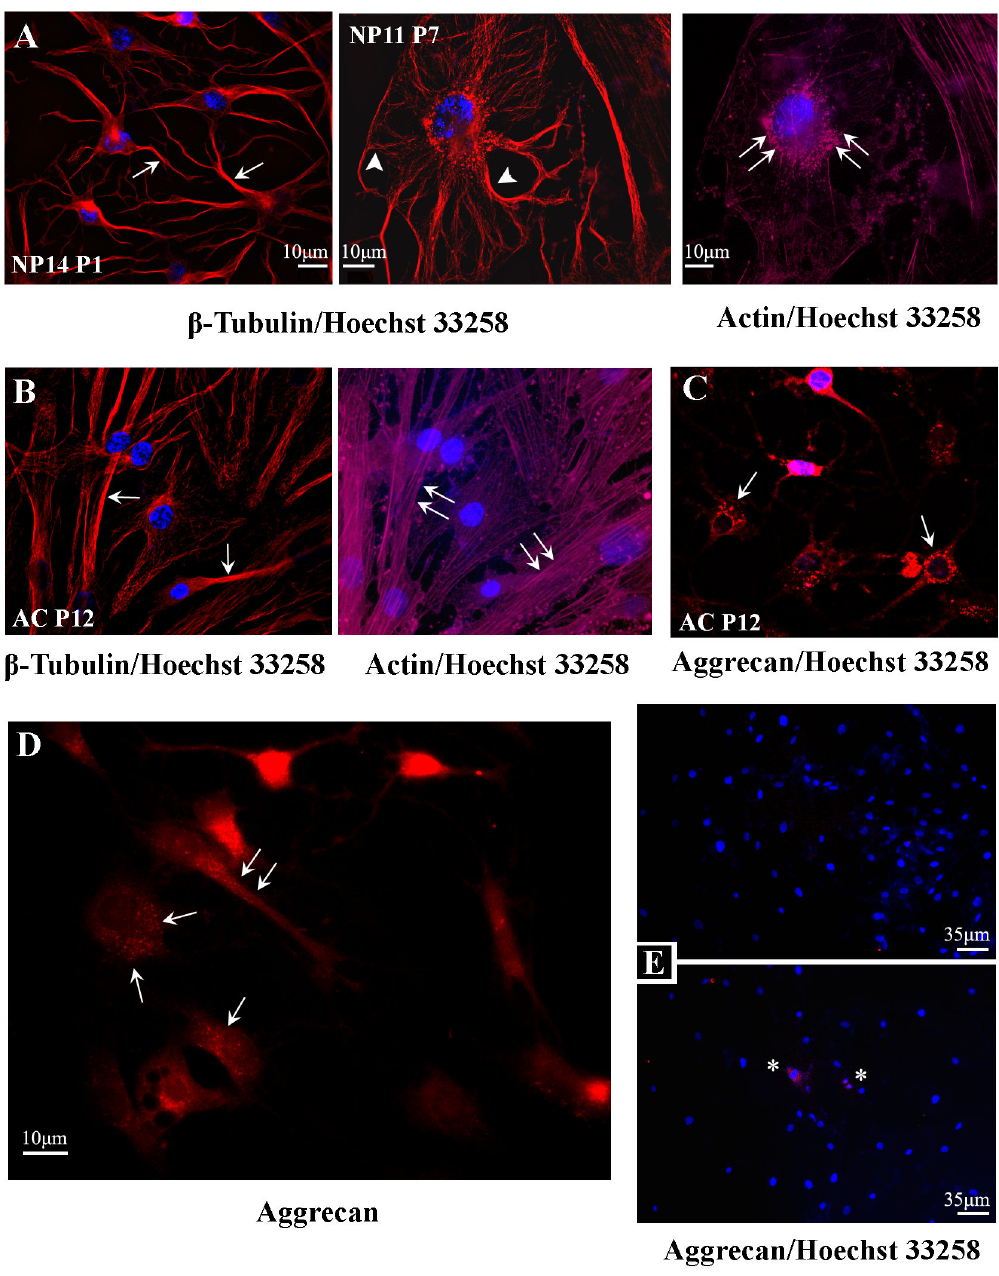
Figure 2. Cytoskeletal and chondrocyte phenotypic markers in cultured NP cells. NP cell cultures were fixed, immunostained and imaged with deconvolution microscopy ( A ) β-tubulin immunostaining (red) reveals elaborate microtubule cytoskeletons in NP cells (arrows), especially in the rare large notochordal-like cells (arrowheads), while phalloidin staining (magenta) shows that F-actin is organized in focal adhesions under the cell body (double arrows); nuclei are stained blue with Hoechst. ( B ) In contrast, AC cells exhibit polarized cell bodies, lesser microtubule branching (arrows), and F-actin forms intense stress fibers (double arrows). Staining with the BC-3 antibody (red) that recognizes the neoepitope on human aggrecan that is created after cleavage within the sequence TEGE373- ARGS by aggrecanases activity, decorated the cytoplasm of both ( C ) AC cells and ( D ) NP cells. In both cell types the 374 staining pattern was consistent with a vesicular distribution (arrows). ( E ) Aggrecan staining was not detected when chondroitinase was omitted (upper panel) or when the reaction was allowed to proceed at 4° C (asterisk indicate cells at mitosis) (NP6 P10, C7). NP tissue indicate fresh tissue sample, NP numbers indicate patient sample, and P the culture passage; all cells were visualized with a 63x oil immersion lens. doi: 10.1371/journal.pone.0082045.g002 PLOS ONE |